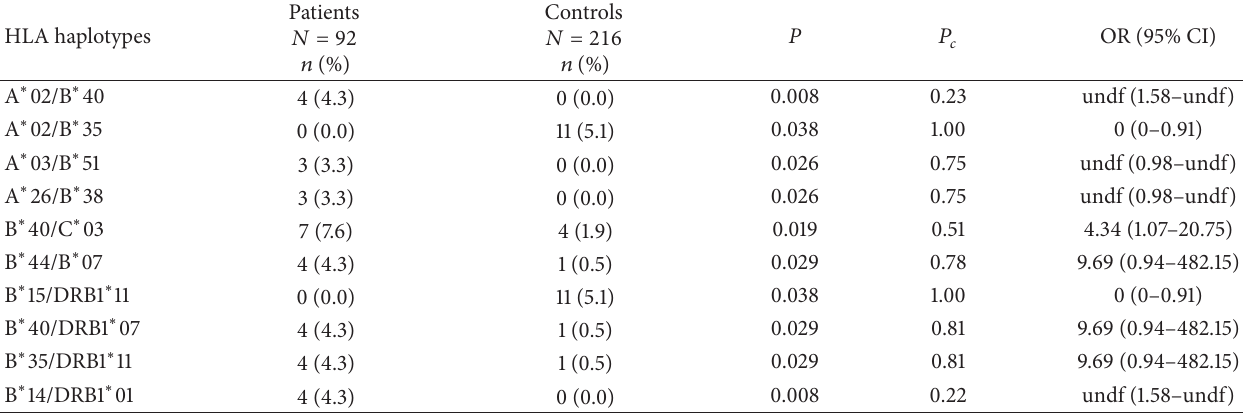
Table 5: HLA haplotype associations between nonsmokers, chronic periodontitis patients, and controls. HLA